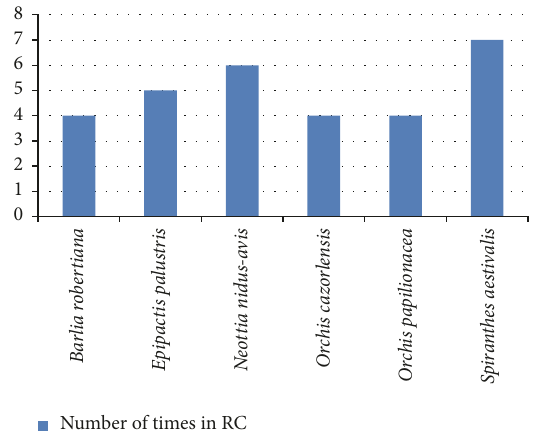
Figure 4: Species mostly included in regional catalogues